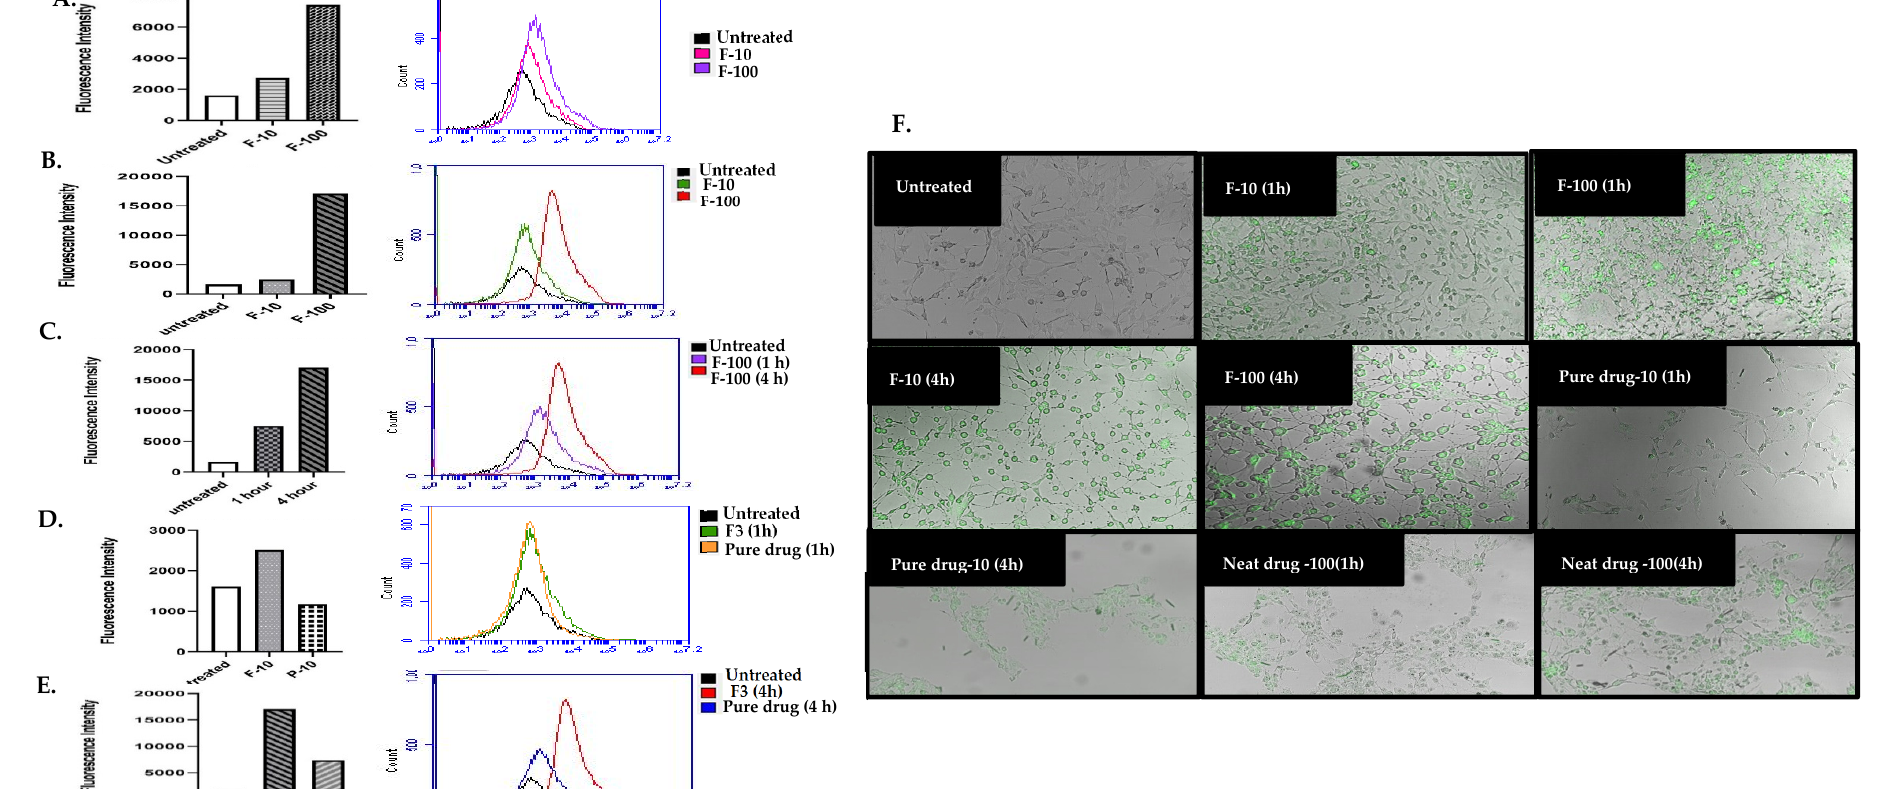
Figure 9. Cellular uptake of the curcumin-loaded SEDDS (F3 formulation) in NIH3T3 fibroblasts, determined by FACS. ( A ) one-hour cell incubation at different doses of F3 SEDDS; ( B ) four-hour cell incubation at different doses of F3 SEDDS; ( C ) time-dependent uptake of F3 SEDDS at 100 µg/mL curcumin dose; ( D ) F3 SEDDS vs. pure drug at 10 µg/mL curcumin after 1 h cell incubation; ( E ), F3 SEDDS vs. pure drug at 100 µg/mL after 4 h cell incubation; and ( F ) fluorescence microscopy images. F10: F3 SEDDS at 10 µg/mL curcumin. F100: F3 SEDDS at 100 µg/mL curcumin.